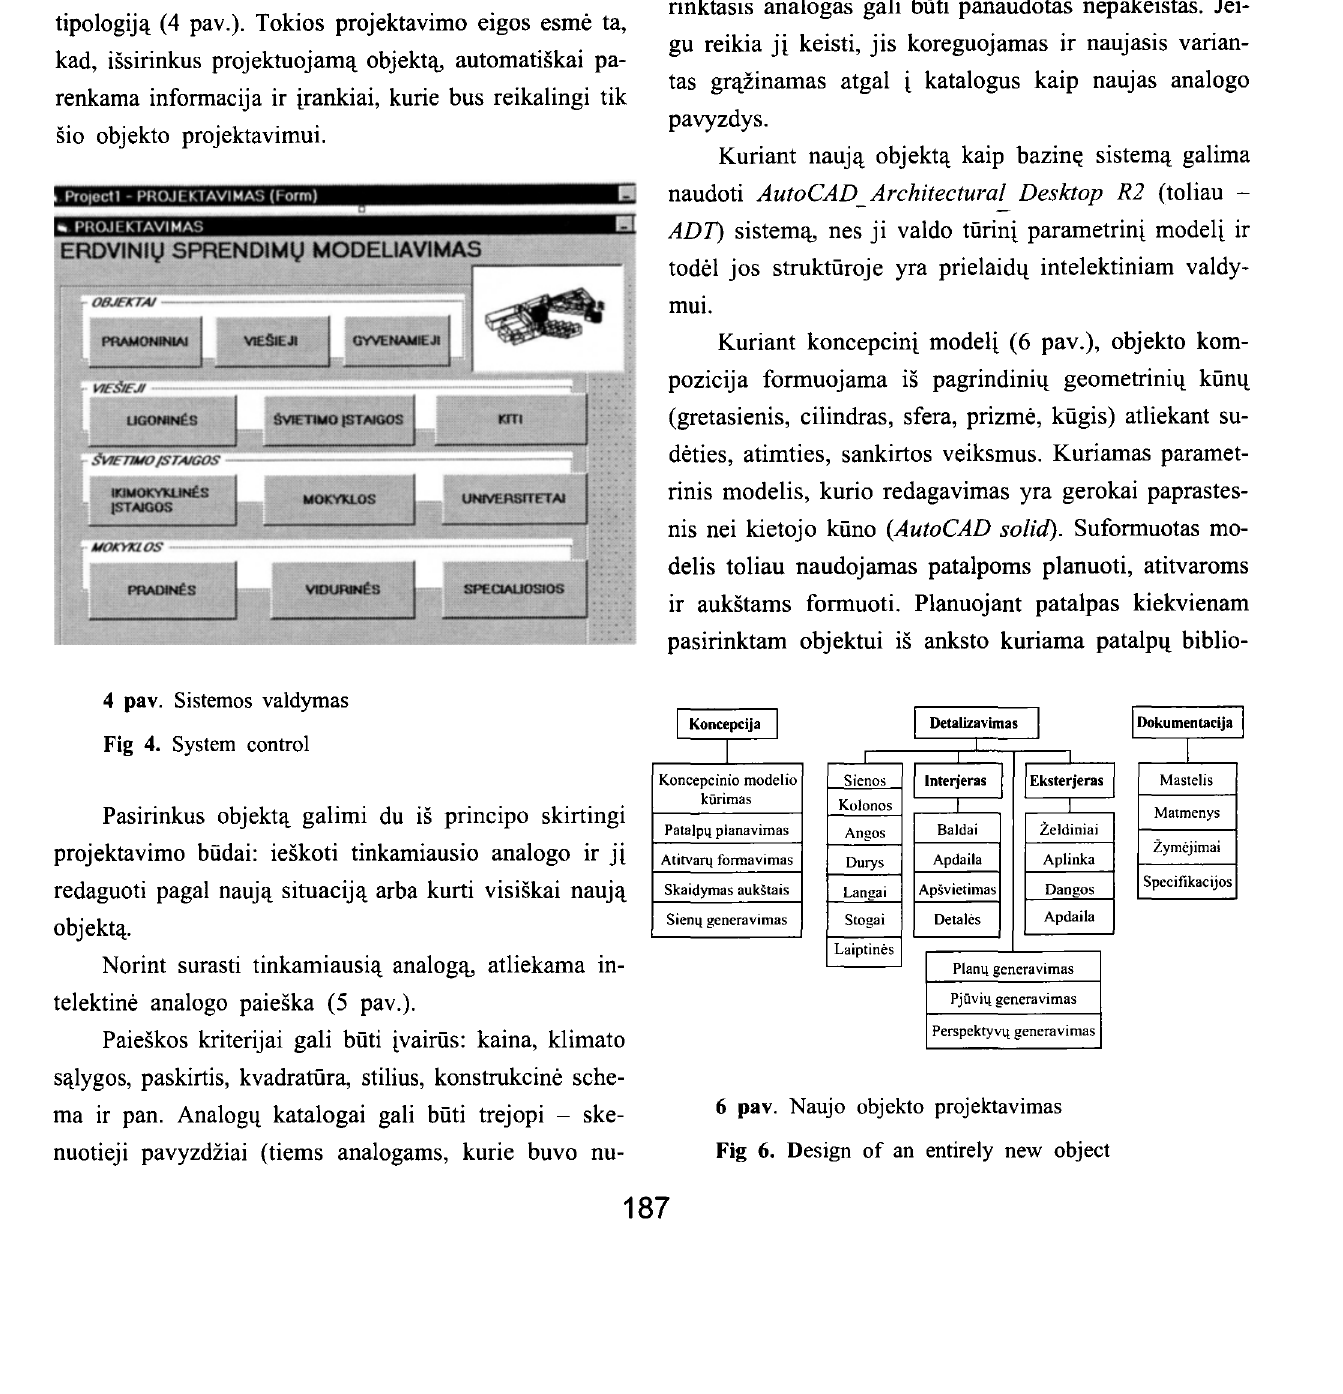
Fig 6. Design of an entirely new